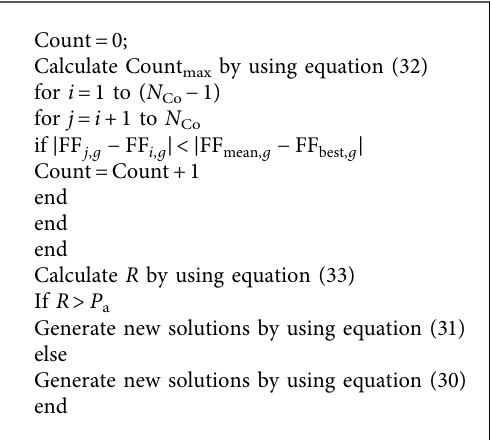
Table 1: Five harmonic flows injected into loads in distribution power networks. Harmonic Magnitude (%) Angle ( ° ) order 0.765; 0.627; 0.248; 0.127; 5; 7; 11; 13; 17